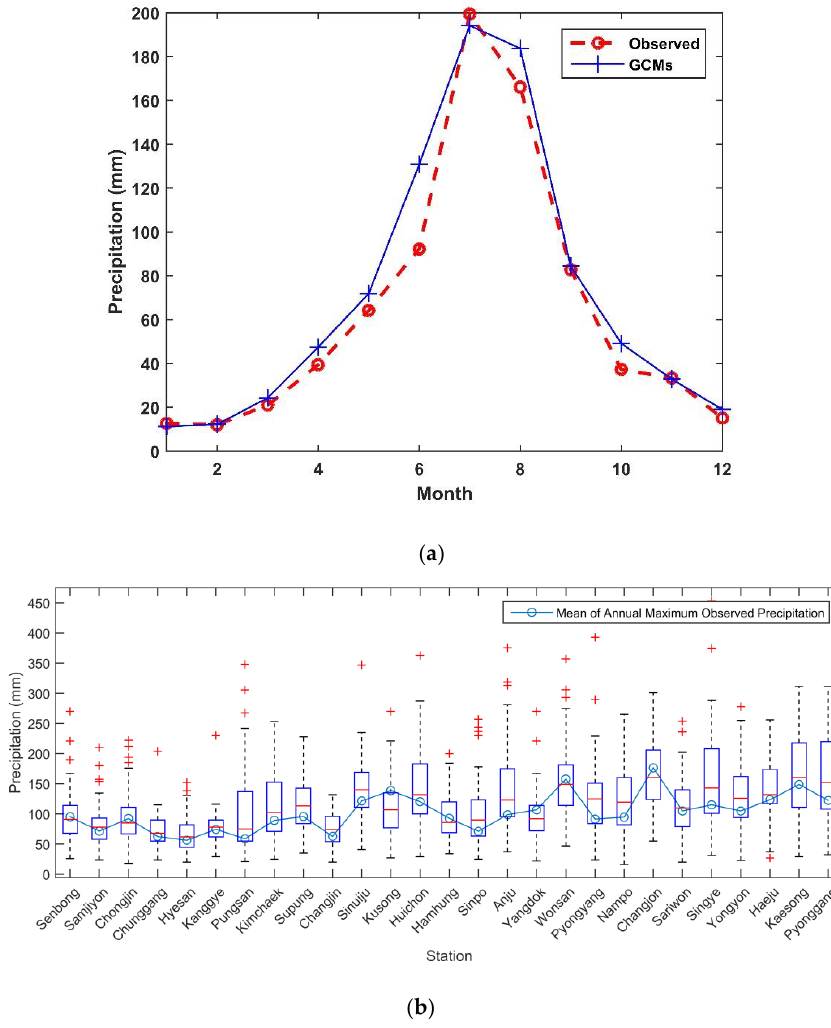
Figure 3. Comparison of the observed precipitation with simulated precipitation from 25 GCMs. ( a ) Monthly precipitation and ( b ) annual maximum daily precipitation (AMDP) at local scale.